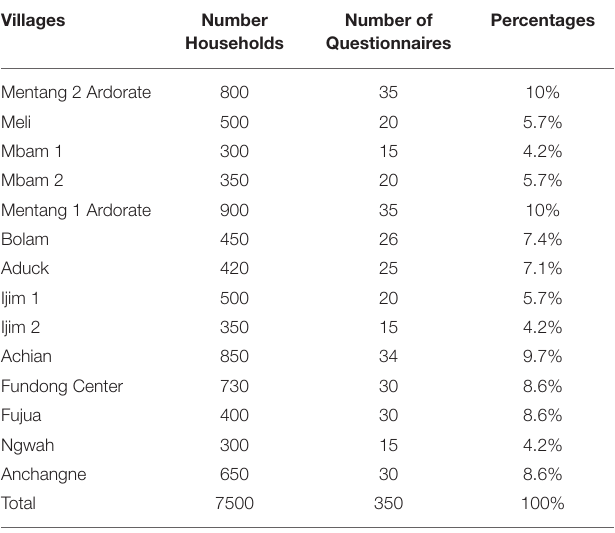
TABLE 1 | Distribution of questionnaires in villages. Villages Number Number of Households Questionnaires